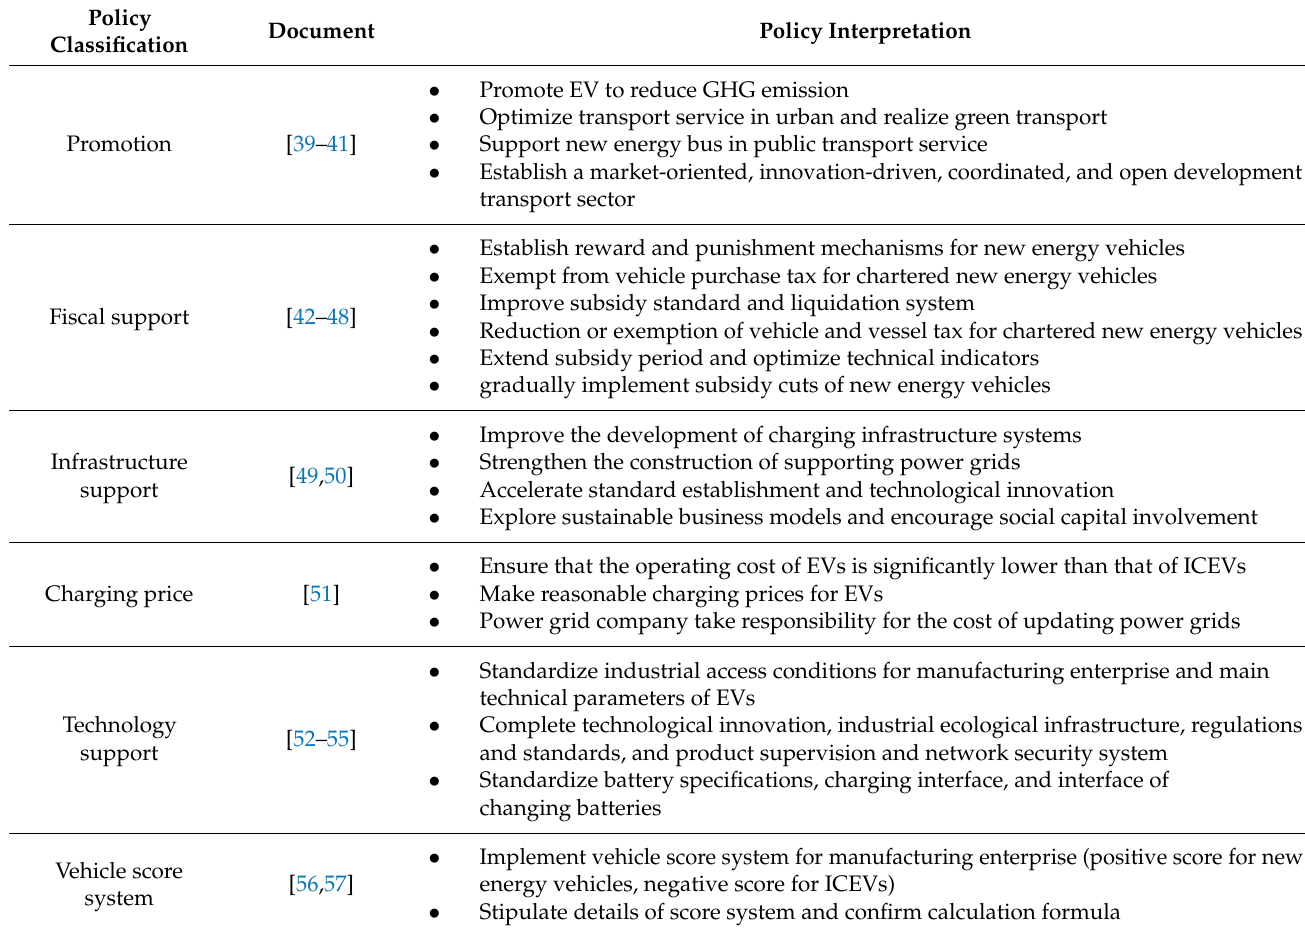
Table 1. EVs supporting policy and